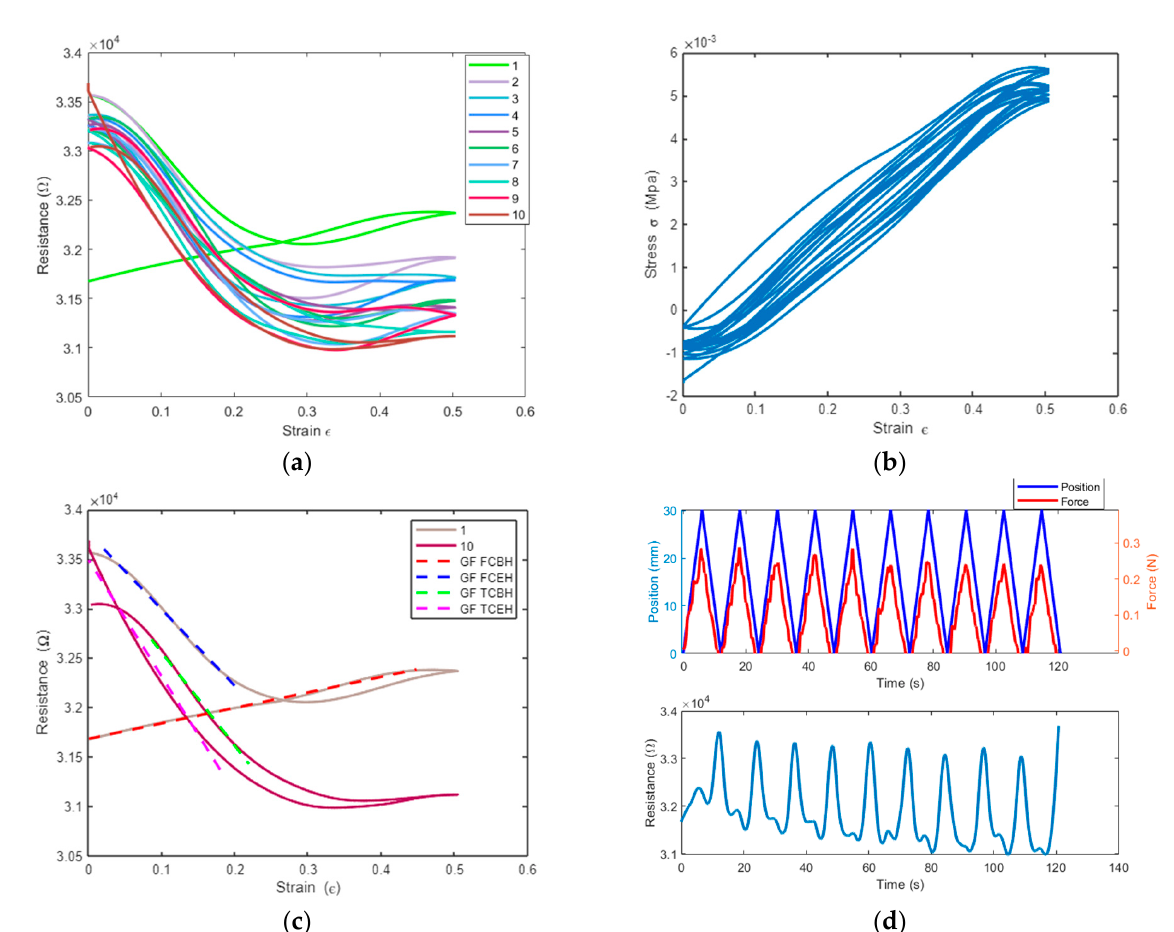
Figure 16. KHS cyclic tensile test results: (a) Resistance vs. strain for ten cycles. (b) Stress vs. strain for ten cycles. (c) Resistance vs. strain and gauge factors for the first and the tenth cycles. (d) Displacement, force, and resistance change over time for ten cycles.